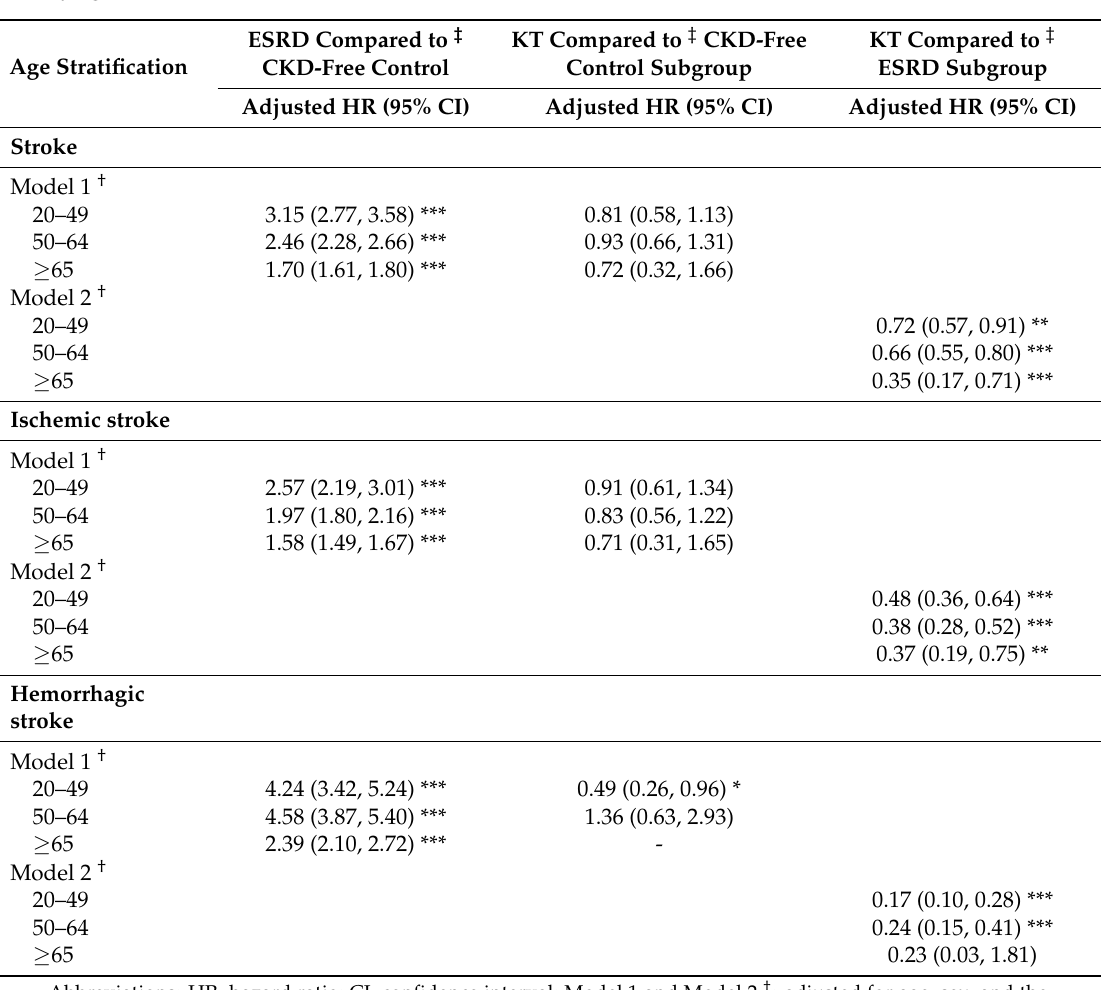
Table 3. Adjusted hazard ratios for stroke among the ESRD, KT, and CKD-free control groups stratified by